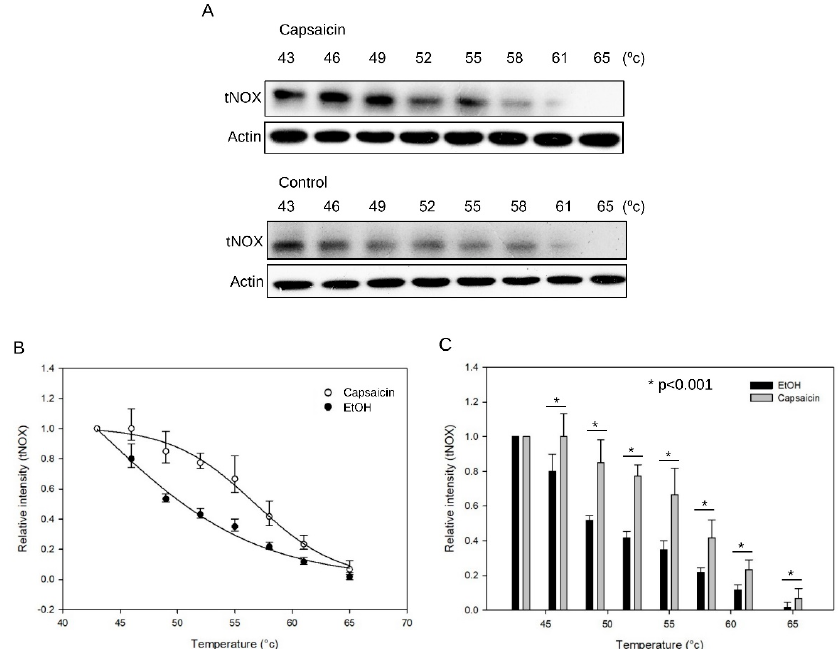
Figure 1. CETSA-based determination of binding between capsaicin and tNOX. ( A ) CETSA was performed as described in the Materials and Methods section. Cell lysates were separated by SDS-PAGE and analyzed by Western blotting. β -Actin was detected as an internal control. Representative images are shown. ( B ) CETSA curves of tNOX in T24 cells were determined in the absence and presence of capsaicin. Each band intensity of tNOX was normalized with respect to that obtained at 43 ° C. The graphs are an average of three independent experiments. ( C ) The quantification of relative intensity of tNOX protein versus increased temperature from three independent experiments (* p <